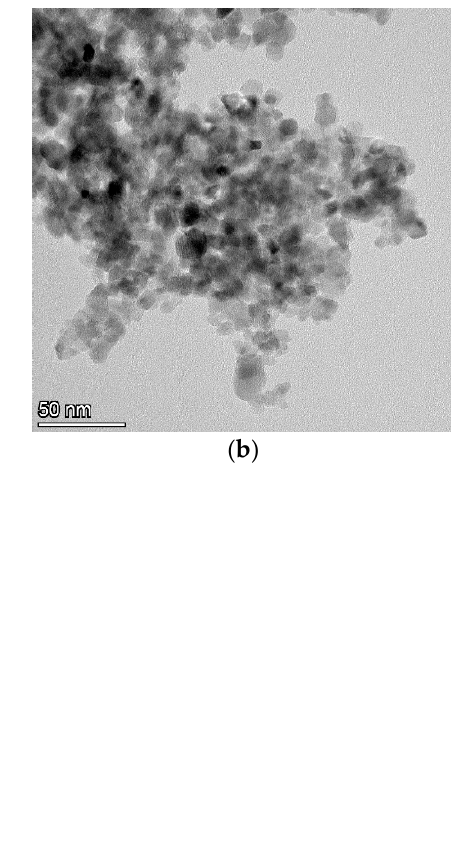
Figure 6. FESEM analysis on N-doped TiO 2 powder in ( a ) ×100,000 and ( b ) ×150,000 magnification.